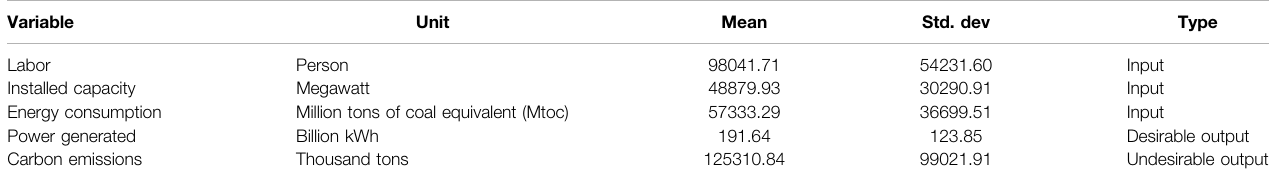
TABLE 1 | Descriptive statistics of inputs and outputs.